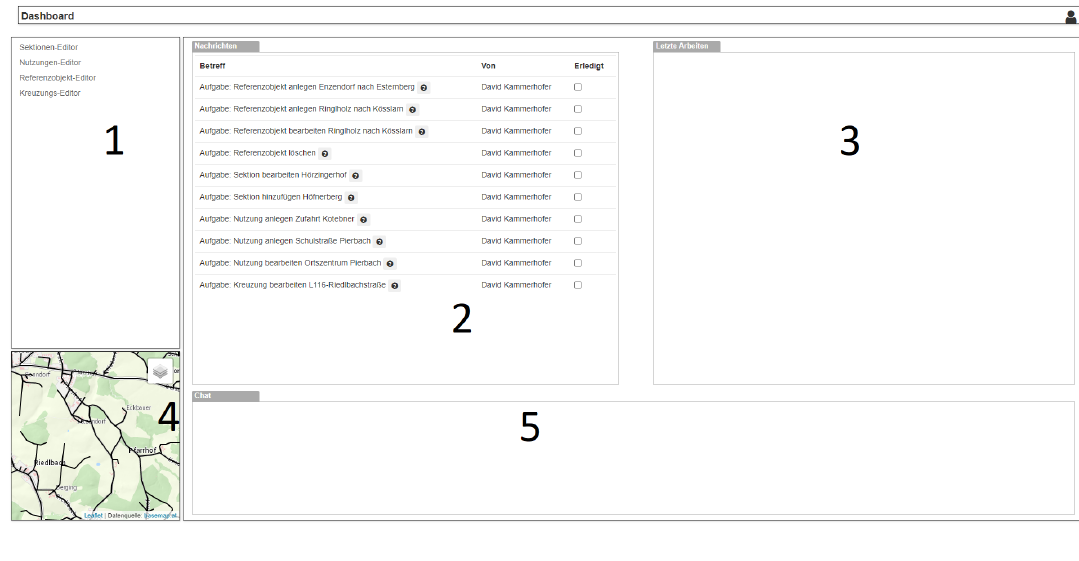
Figure 3. The implemented dashboard of the web application. It shows the list of links to the other apps (1); the list of tasks of the experiment with the link to pop-ups for further information (2); the suggestion of an implementation of a list of completed tasks (3); a small overview map (4); the suggestion of an implementation of a chat function (5).